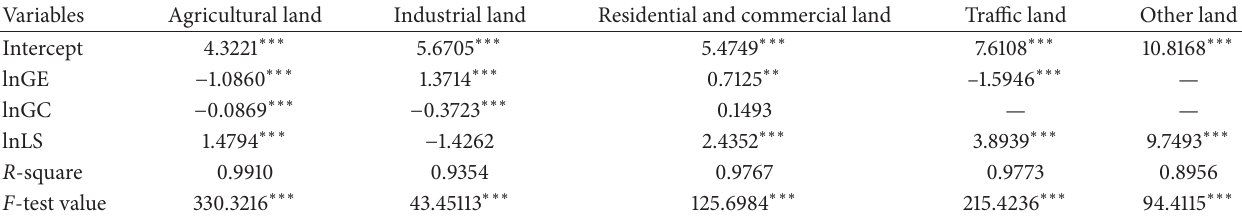
Table 8: Coefficients of the five models.